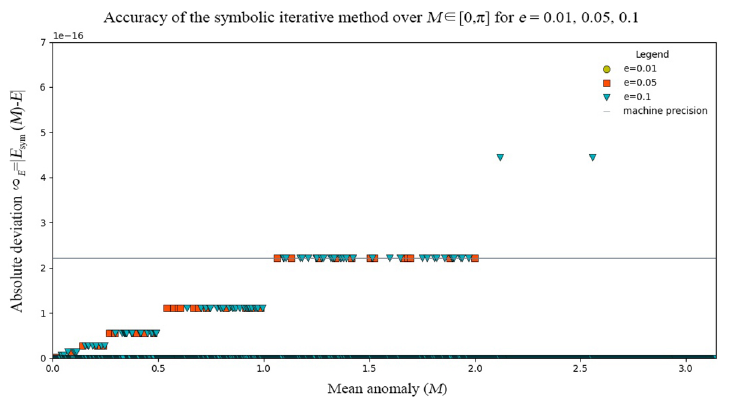
E symbol ( M ) − E (cid:31) (cid:31)